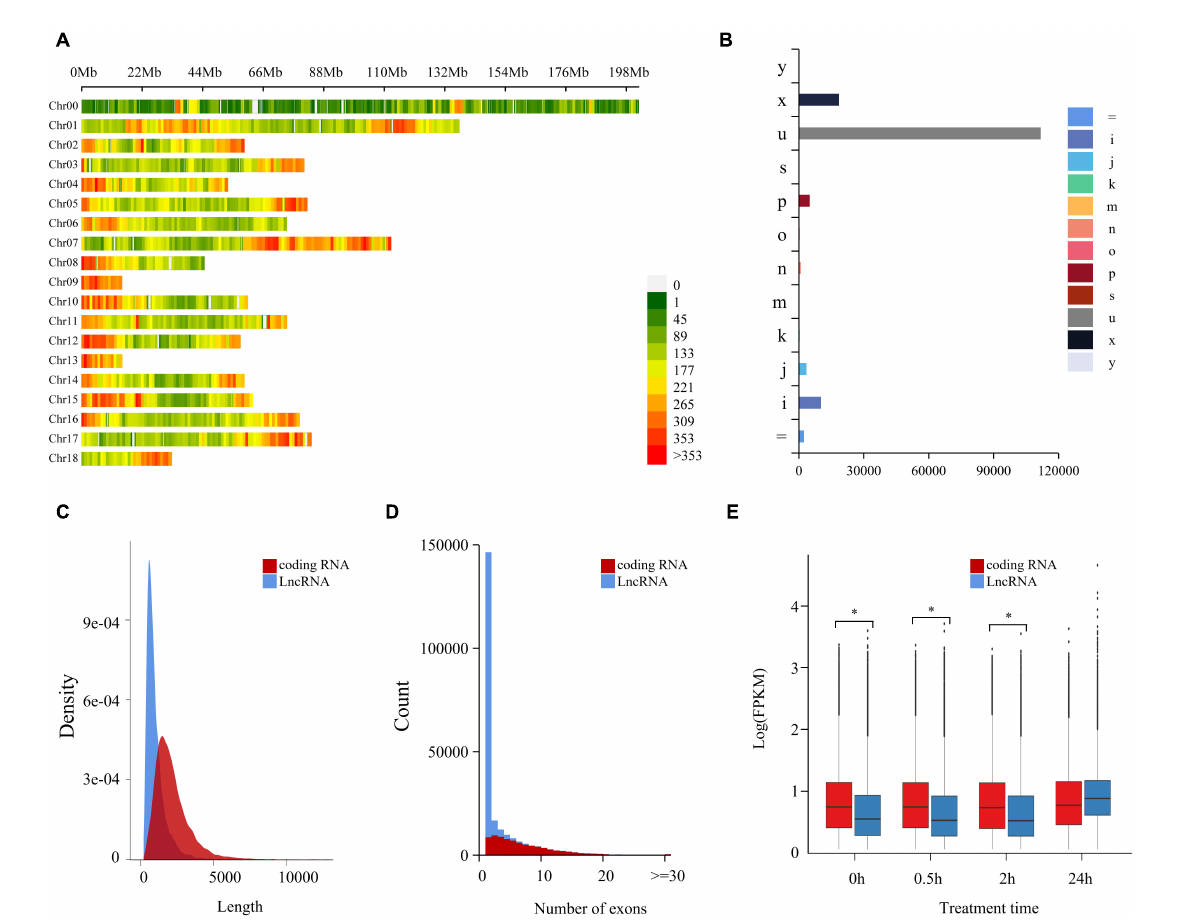
FIGURE1 Genome-wide identification and characterization of LncRNA in quinoa root under salt stress. (A) Chromosome distribution of LncRNAs in quinoa reference genome. The LncRNAs density was demonstrated by the coloration. Numbers on the right hand of color bar indicated the amount of LncRNAs within 1 Mb window size. Chr: chromosome. (B) Annotation classification of LncRNAs based on reference gene set. Class codes were generated by Cuffcompare against quinoa reference gene set ( Chenopodium quinoa v1.0). Different groups were represented in different colors and marked with characters and symbols. “ = ”: complete, exact match of intron chain; “i”: fully contained within a reference intron; “j”: multi-exon with at least one junction match; “k”: containment of reference (reverse containment); “m”: retained intron(s), all introns matched or retained; “n”: retained intron(s), not all introns matched or retained; “o”: other same strand overlap with reference exons; “p”: possible polymerase run-on (no actual overlap); “s”: intronic match on the opposite strand (likely a mapping error); “u”: unkown, intergenic; “x”: exonic overlap on the opposite strand; “y”: contains a reference within its intron(s). (C) Length distribution of coding RNAs and LncRNAs. (D) Exons distribution of coding RNAs and LncRNAs. (E) The expression patterns of coding RNAs and LncRNAs at different time points of salt treatment. * p < 0.05 (Student’s